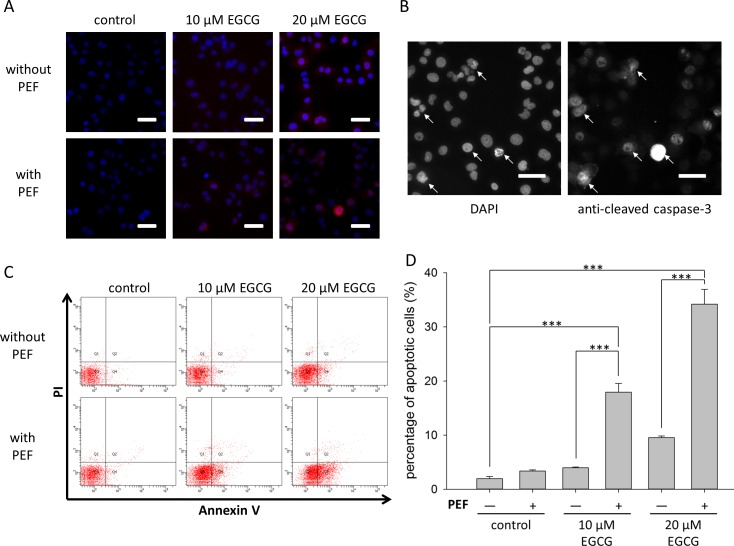
Effects of PEF on EGCG-induced apoptosis in PANC-1 cells.PANC-1 cells were treated for 24 h with EGCG (10 or 20 μM) alone or combined with 60 V/cm PEF. (A) The nuclei morphology was analyzed using DAPI staining (blue), and the apoptotic cells were revealed by cleaved caspase-3 labeling (red). Scale bar = 10 μm. (B) The double staining of cells co-treated with 20 μM EGCG and 60 V/cm PEF was presented as two separate enlarged images. The left and right images represented the DAPI-stained nuclei and the signals of cleaved caspase-3, respectively. It was observed that cells showing nuclear condensation (arrowheads) were also labeled with anti-cleaved caspase-3 (arrowheads). Scale bar = 10 μm. (C) Double staining Annexin V/PI and flow cytometry were employed to analyze the apoptotic effect of the combination treatment. (D) Apoptotic cells were considered as the sum of early and late apoptotic cells. The percentage of apoptotic cells were presented as the mean ± S.D. of triplicate experiments. A significant increase of apoptotic cells was identified in the cells co-treated with 10 μM EGCG and 60 V/cm PEF. Similarly, co-treatment with the PEF and 20 μM EGCG significantly increased the apoptotic cell number of PANC-1. The “+” means that the PEF was involved in the treatment, and the “-” means the PEF was not involved. (***, p<0.001 compared to corresponding control).